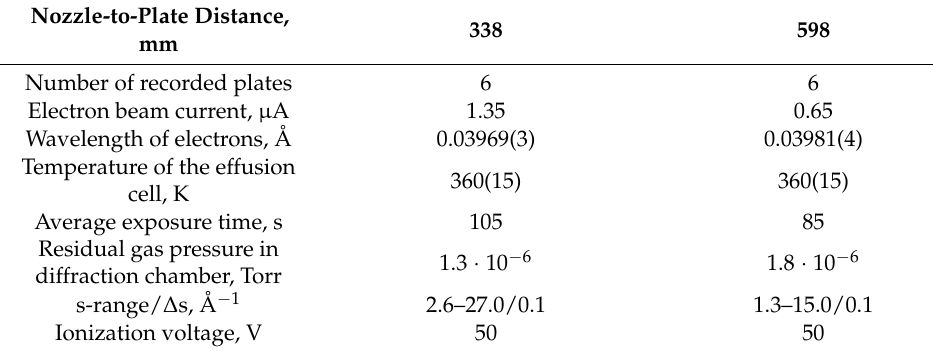
Table 4. Conditions of the synchronous GED/MS